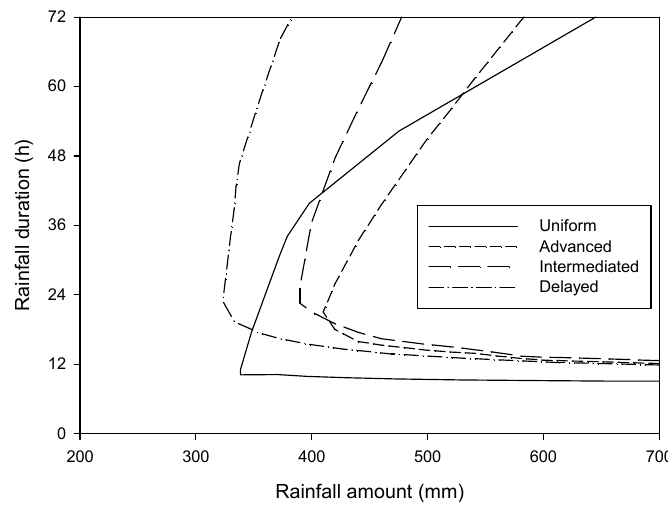
Figure 14. Threshold of slope instability induced by rainfall and lateral flow.